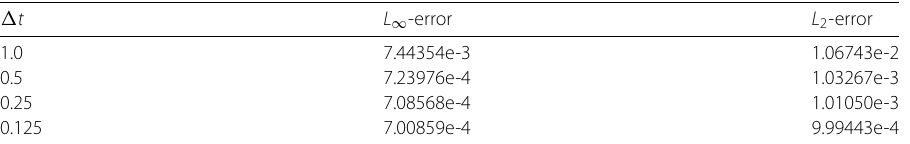
Table 1 The errors at T = 10 of NSFD scheme (39) with h = 0.5 (cid:3) t L ∞ -error